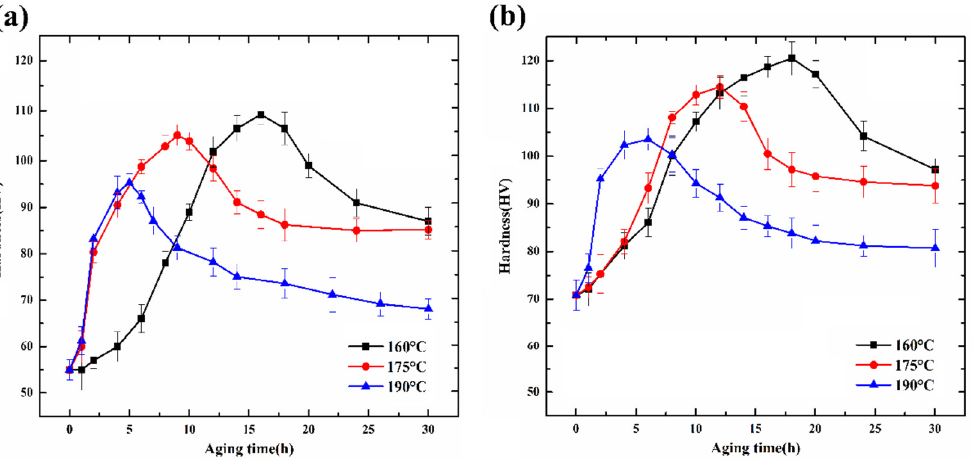
Figure 1. Aging hardness curves of ( a ) Al-7%Si-0.3%Mg-0.3%Cr (wt.%) alloy and ( b ) Al-7%Si-0.3%Mg-0.3%Cr-1.5%Cu (wt.%) alloy under different temperatures.